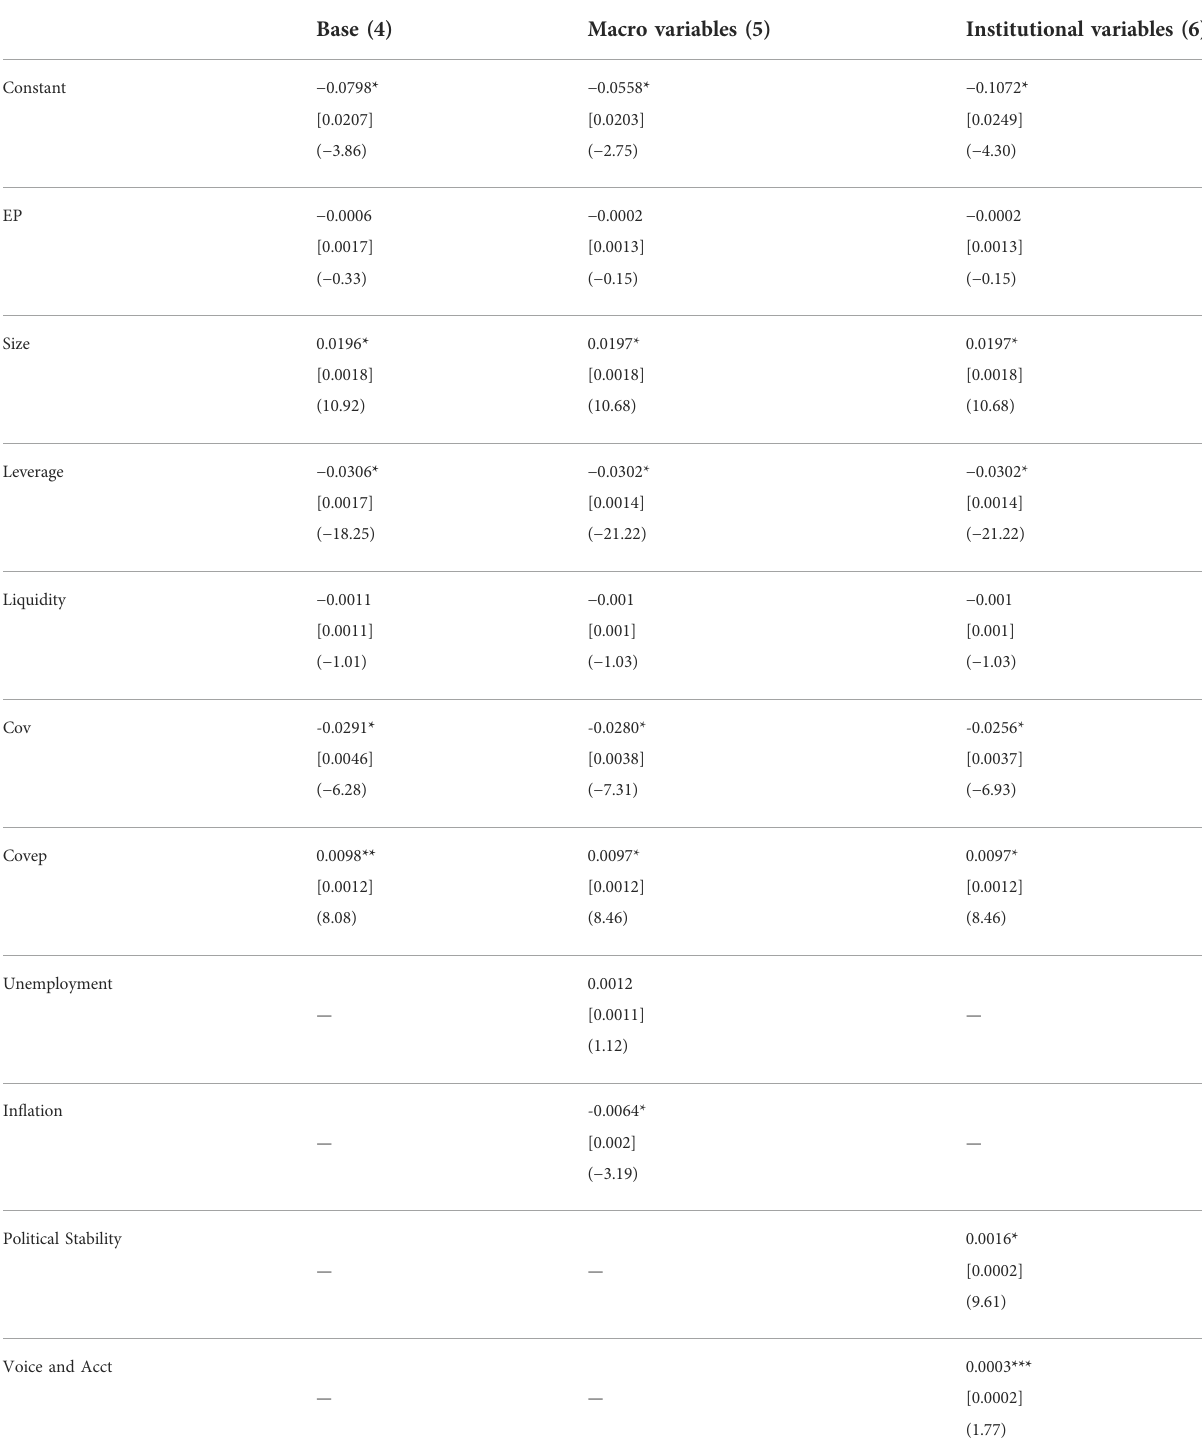
TABLE 3 Robustness of determinants of fi nancial performance